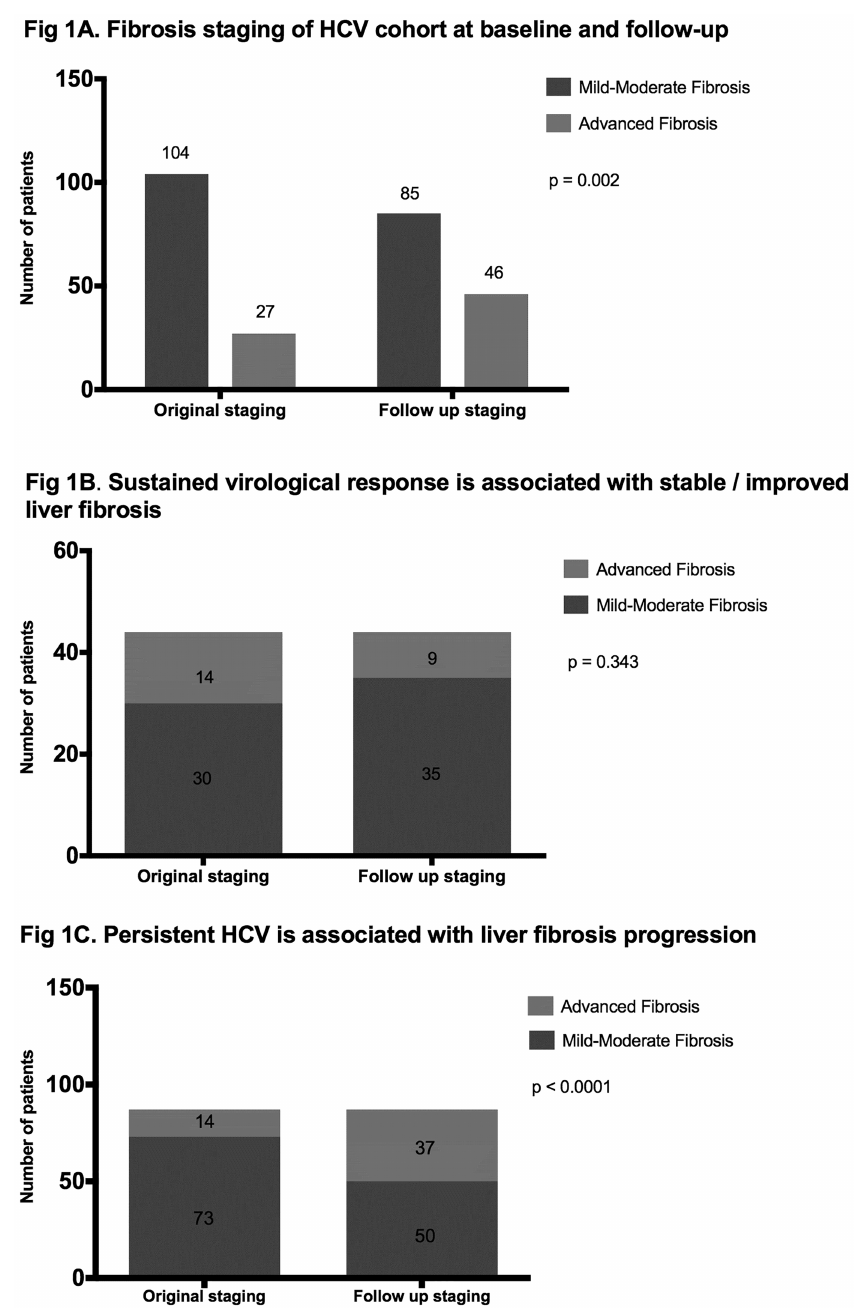
Fig 1. A. Fibrosis staging of HCV cohort at baselineand follow-up. B. Sustainedvirological response is associated with stable / improvedliver fibrosis. C. Persistent HCV is associated with liver fibrosis